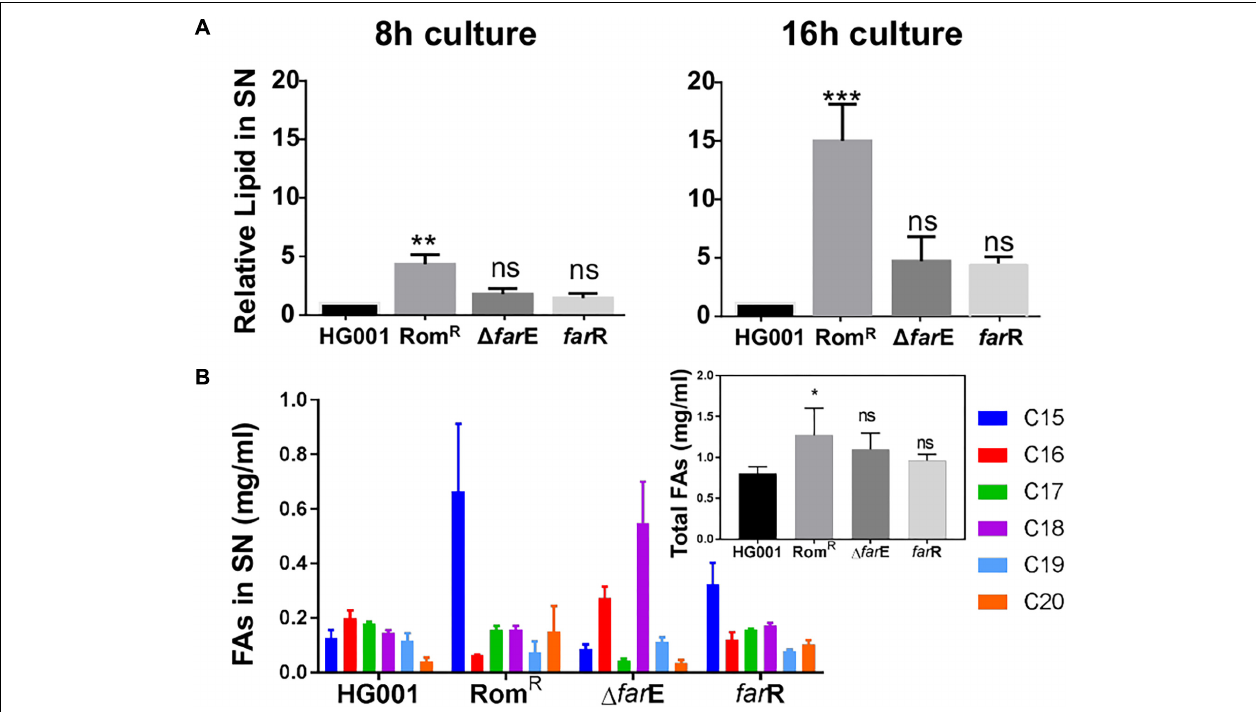
FIGURE 4 | Comparison of release of lipids and total FAs into the supernatant. (A) Release of lipids. The S. aureus clones (Rom R clone, Rom R (cid:49) farE , and Rom R (cid:49) farR ) were aerobically cultured in TSB medium for 8 and 16 h. The supernatants were filtrated and 100 µ l of each sample were mixed with FM5-95 to a final concentration of 5 µ g/ml. Fluorescence was measured with a Tecan microplate reader using excitation at 565 nm and emission at 660 nm. All experiments were performed in triplicate. The relative lipids in the supernatant were relativized to the HG001 value. Error bars indicate standard error. Statistical significances between mutant clones Rom R , (cid:49) farE (Rom R (cid:49) farE ), farR [Rom R (pCX- farR )] with the wild type HG001 were analyzed by 1-way ANOVA: not significant P > 0.05, ∗ P < 0.05, ∗∗ P < 0.01, ∗∗∗ P < 0.001. (B) Comparison of FAMEs (C15 to C20). The FAs in the supernatants of 16 h cultures of HG001, Rom R clone, (cid:49) farE (Rom R (cid:49) farE ), and farR [Rom R (pCX- farR )] were qualitatively and quantitatively analyzed by GC-MS. The FAs from C15 to C20 were assigned different colors. The total FAs for each clone are shown in the inserted graph. Experiments were performed independently in duplicate. Error bars indicate standard error. Statistical significances between mutant clones Rom R , (cid:49) farE (Rom R (cid:49) farE ), farR [Rom R (pCX- farR )] with the wild type HG001 were analyzed by 1-way ANOVA: not significant P > 0.05, ∗ P < 0.05, ∗∗ P < 0.01, ∗∗∗ P <